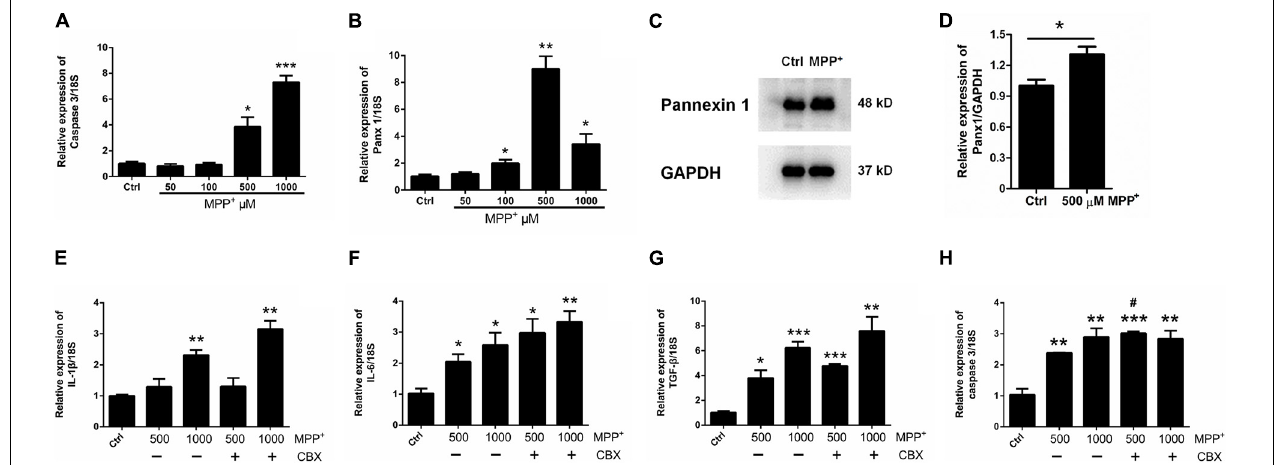
FIGURE 2 | Effect of CBX on MPP + -induced apoptosis in cultured astrocytes. (A,B) The effect of different doses of MPP + (0, 50, 100, 500, and 1,000 µ M) on the expression of caspase 3 and Panx 1 by qPCR assay. (C,D) western blotting analysis of Panx 1 expression after treatment with 500 µ M MPP + . Protein levels were quantified and normalized to the GAPDH levels. (E–H) Influence of CBX (100 µ M) on the expression of caspase 3 and selected inflammatory cytokines IL-1 β , IL-6, and TGF- β in MPP + -induced astrocyte apoptosis. The data were normalized to 18S mRNA levels, n = 3. All data are mean ± SEM. Statistical comparison for (A,B,E–H) were performed using one-way ANOVA, following by Newman–Keuls Multiple Comparison Test, and for (D) using Student’s t -test. * p < 0.05, ** p < 0.01, *** p < 0.001 compared with control group (0 µ M MPP + , # p < 0.05 compared with the group of 500 µ M MPP +